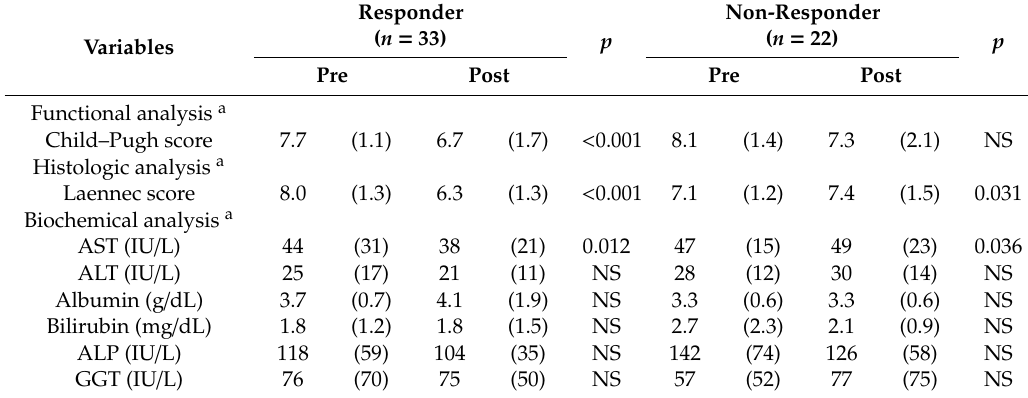
Table 2. Characteristics of responders and non-responders.